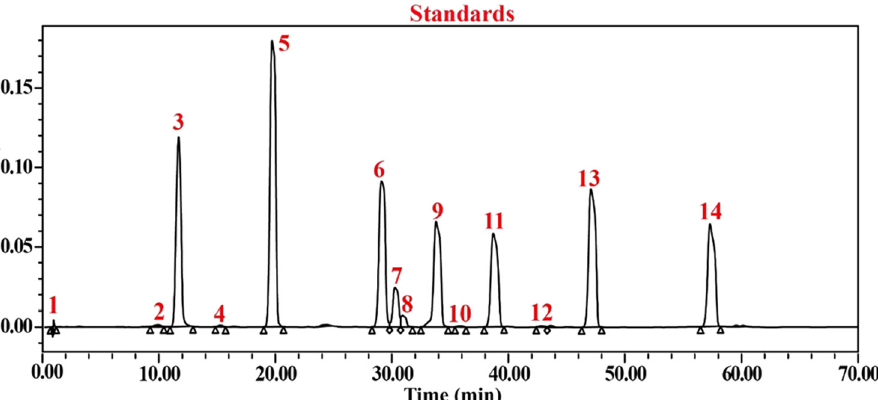
Figure 2: HPLC chromatogram of reference standards for fl avonoids. 1: gallic acid ( 1.847 min ) , 2: ca ff eic acid ( 10.070 min ) , 3: chlorogenic acid ( 11.698 min ) , 4: epicatechin ( 15.256 min ) , 5: ferulic acid ( 19.726 min ) , 6: hyperoside ( 29.110 min ) , 7: luteolin ( 30.259 min ) , 8: rutin ( 30.893 min ) , 9: fi setin ( 33.789 min ) , 10: apigenin - 7 - o - glucoside ( 35.810 min ) , 11: naringenin ( 38.705 min ) , 12: benzene - triol ( 42.768 min )